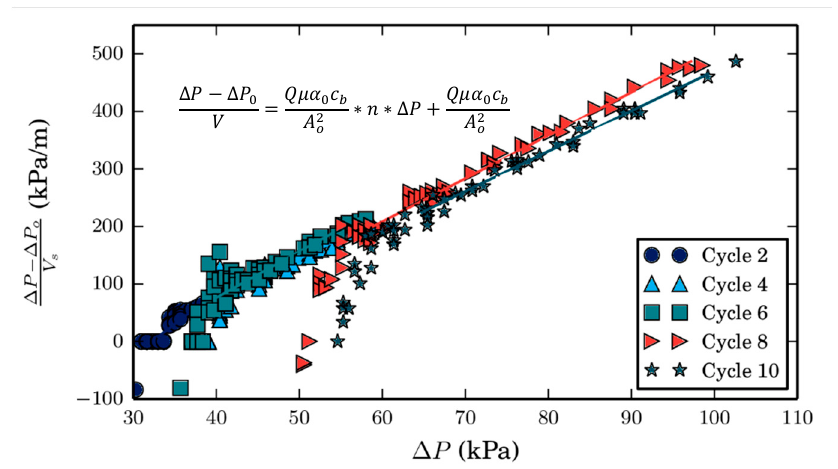
Figure 5. Compressibility of foulant cake layer formed on the membrane surface during the filtration of Cyano-SW. A cycle is defined as the filtration period between two hydraulic backwashes.